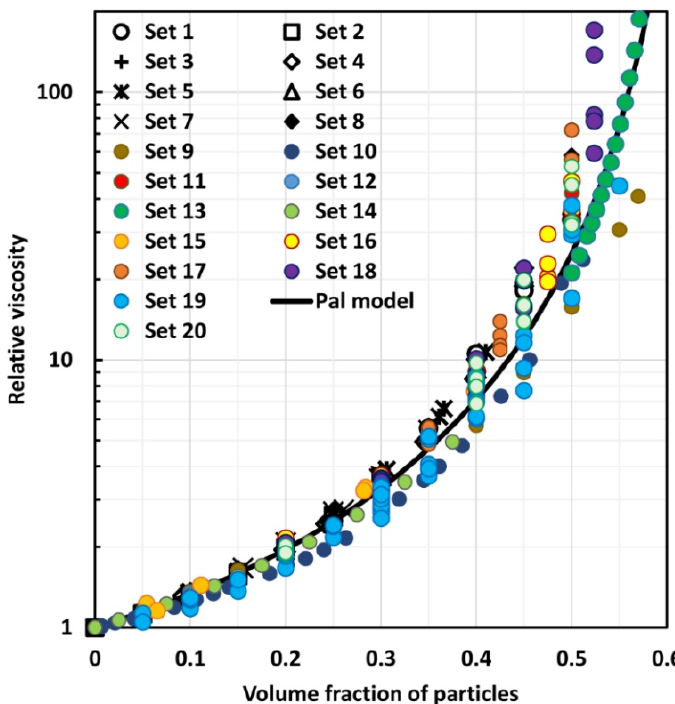
Figure 12. Comparison of experimental viscosity data for suspensions of non-Brownian hard spheres with the prediction of the proposed model ( φ m = 0.637).